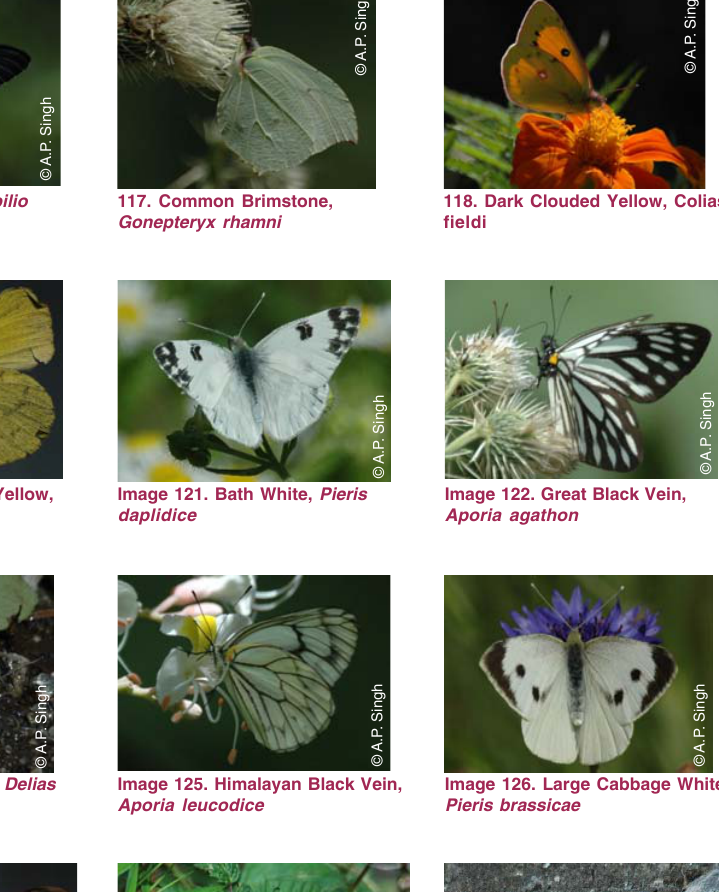
Image 123. Hill Jezebell, Delias belladonna (upper)